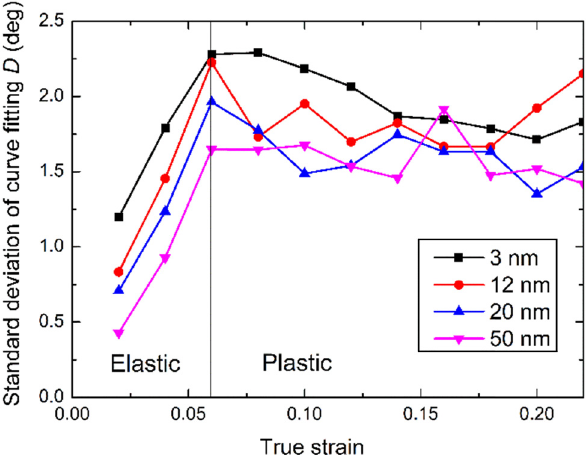
Figure 11: Variation of the standard deviation of grain rotation increment with the strain.